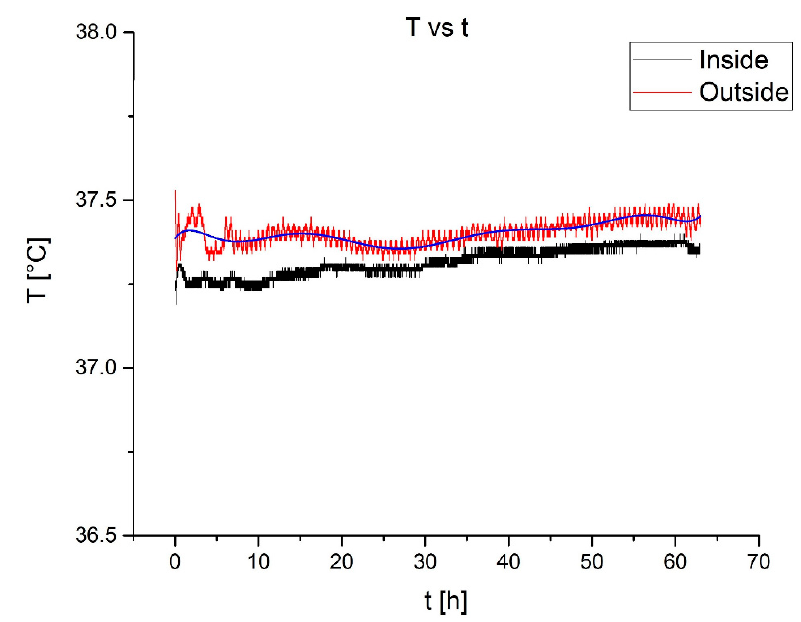
Figure 11. Temperature profiles of the system while working in a CO 2 incubator set to 37 °C. The black line shows the temperature over time inside the culture chamber, while the red one shows the temperature of the surrounding air.